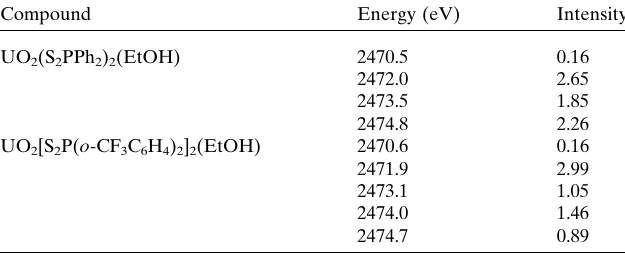
Table 2 The energy and intensity obtained by curve-fitting of the S K -edge XAS for UO 2 (S 2 P R 2 ) 2